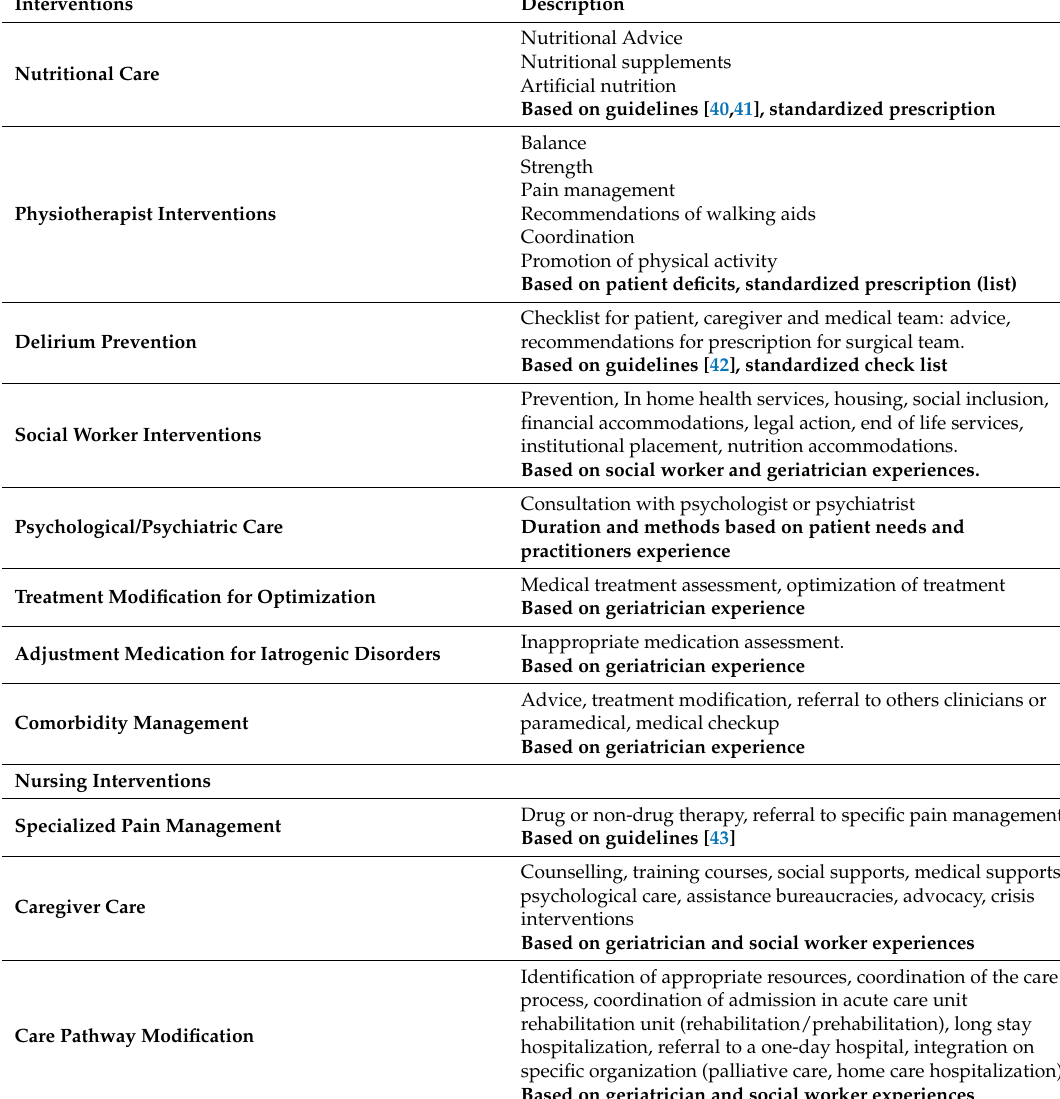
Table 6. Guided geriatric intervention